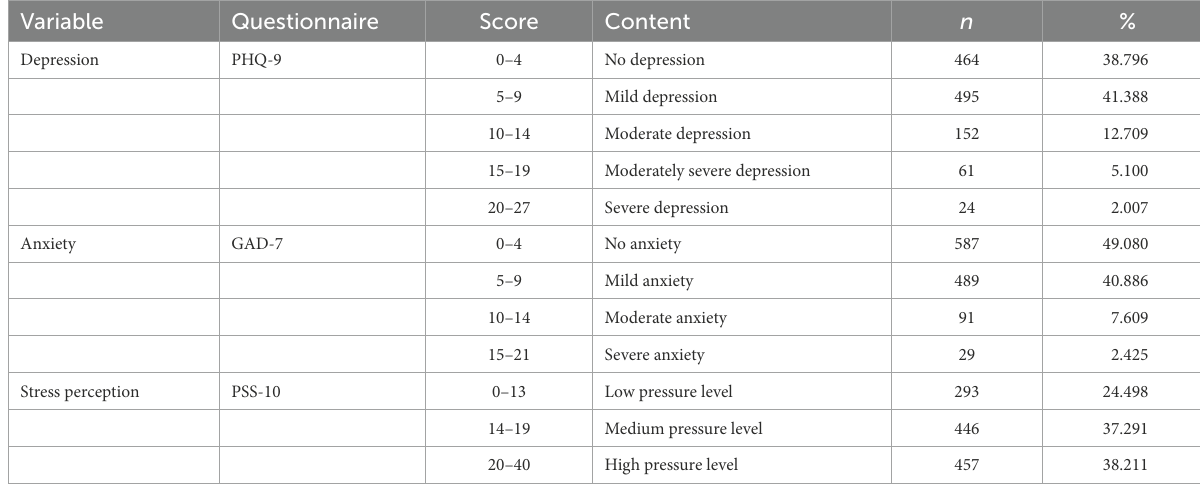
TABLE 2 Measure results of PHQ-9, GAD-7, and PSS-10.